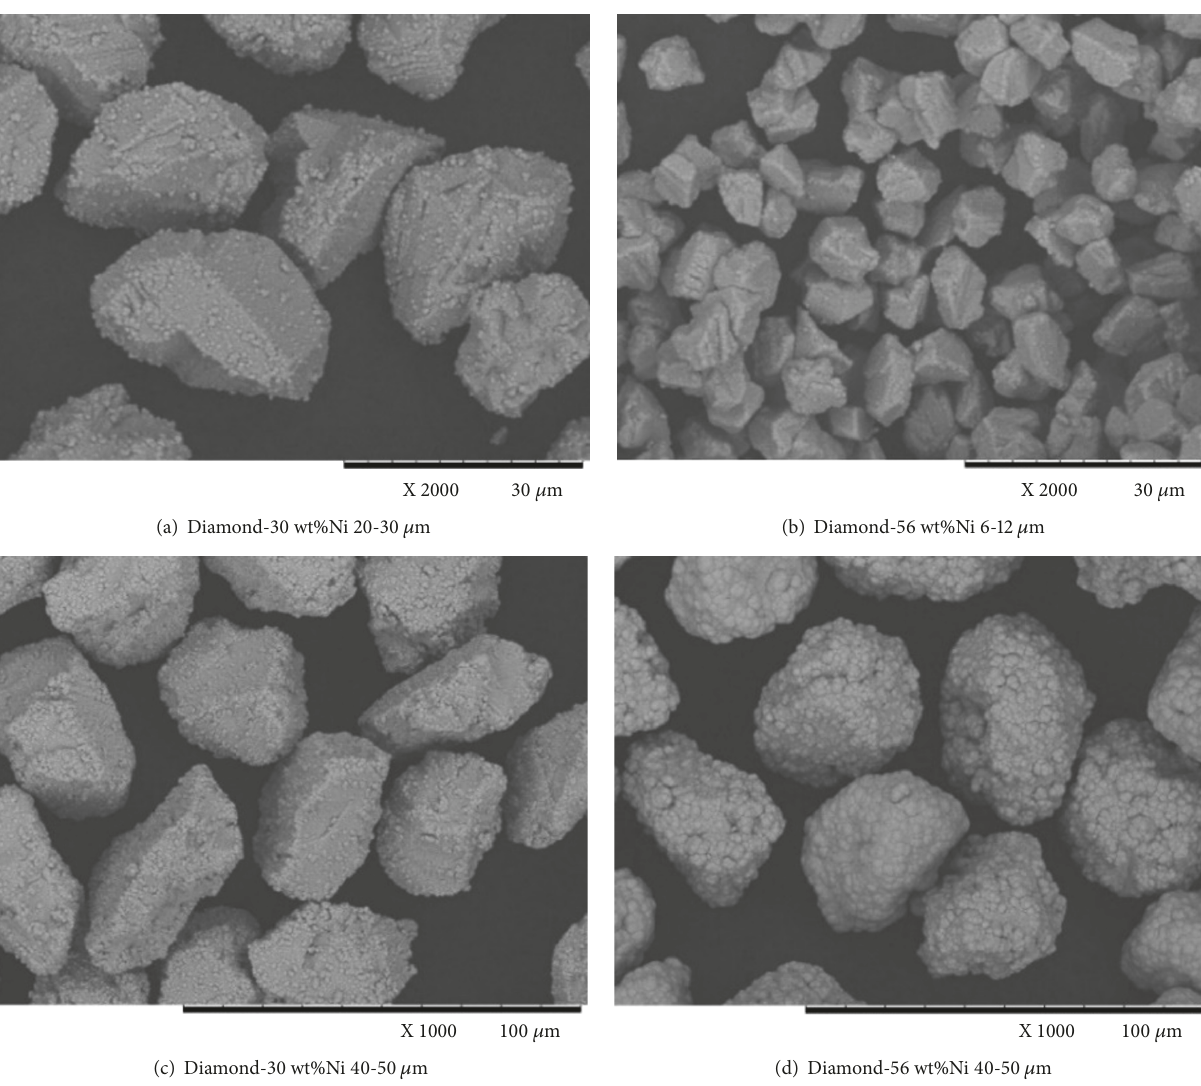
Figure 4: SEM micrographs of nickel-coated diamond